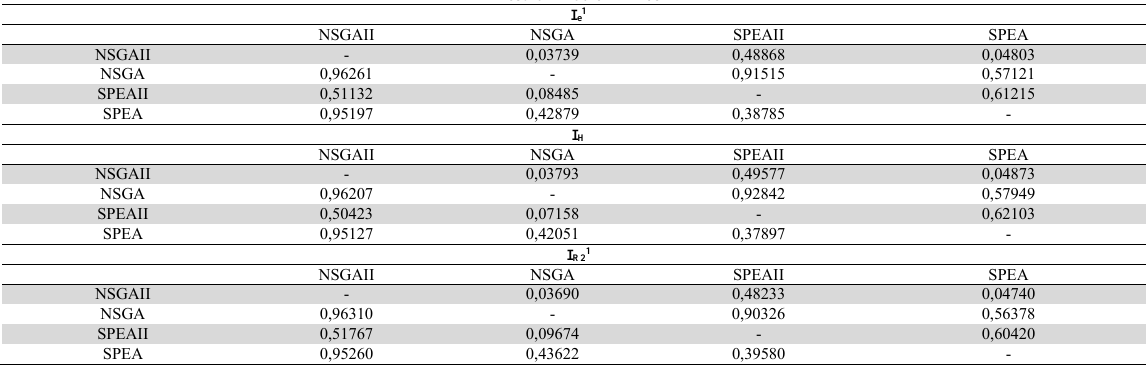
Table 10 Unary epsilon indicator, unary hypervolume indicator and R indicator (MF03)